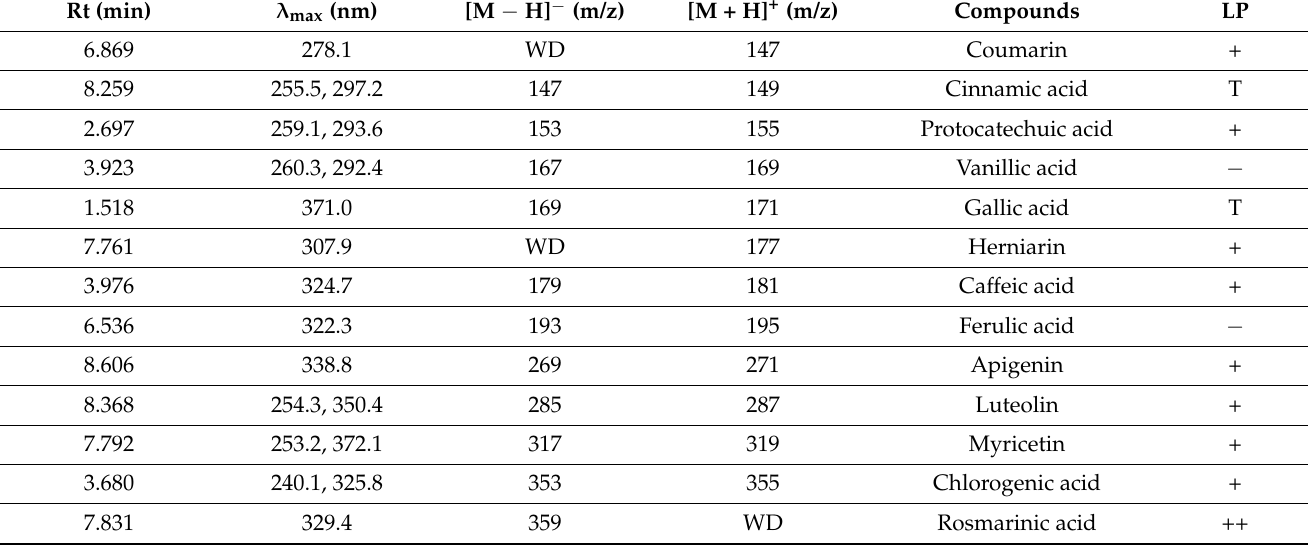
Table 1. Results of UHPLC-MS analysis regarding the presence or the absence of some chemical compounds in LP aqueous